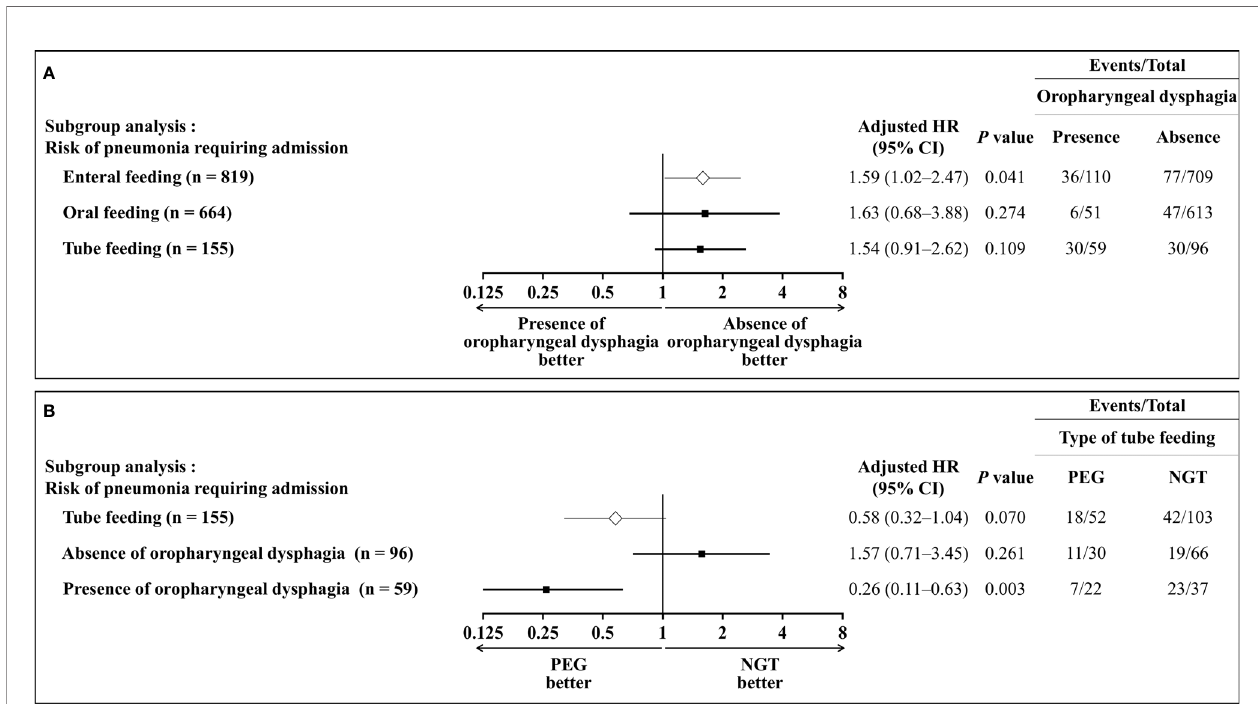
FIGURE 3 | Subgroup analysis of risk of pneumonia requiring admission in older patients with enteral feeding. (A) Based on whether the patients had oropharyngeal dysphagia, the risk of pneumonia requiring hospitalization increased signi fi cantly in overall enteral feeding patients, but not in oral-feeding and tube-feeding patients. (B) Based on the type of tube feeding, PEG did not decrease the risk of pneumonia requiring hospitalization in the overall tube-feeding patients and patients without oropharyngeal dysphagia, but the risk was reduced signi fi cantly in patients with oropharyngeal dysphagia.